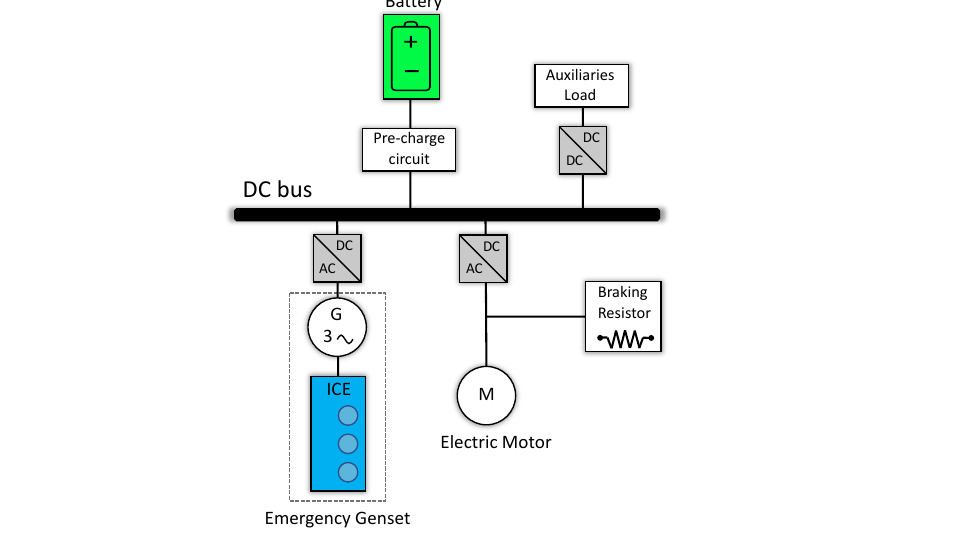
Figure 3. Architecture of the designed electrical